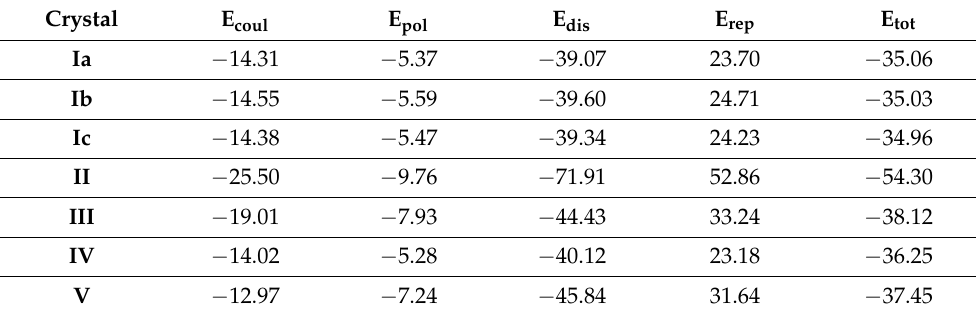
Table 7. Lattice energies (kcal mol − 1 ) partitioned into Coulombic, polarization, dispersion and repulsion contributions for all